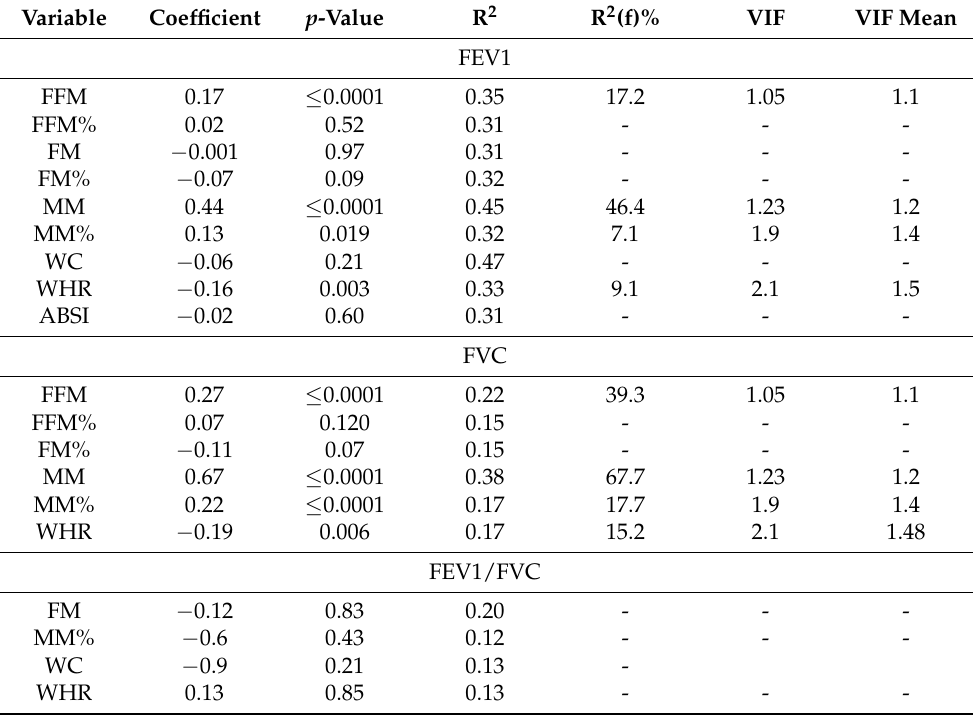
Table 4. Multivariable regression analysis in male